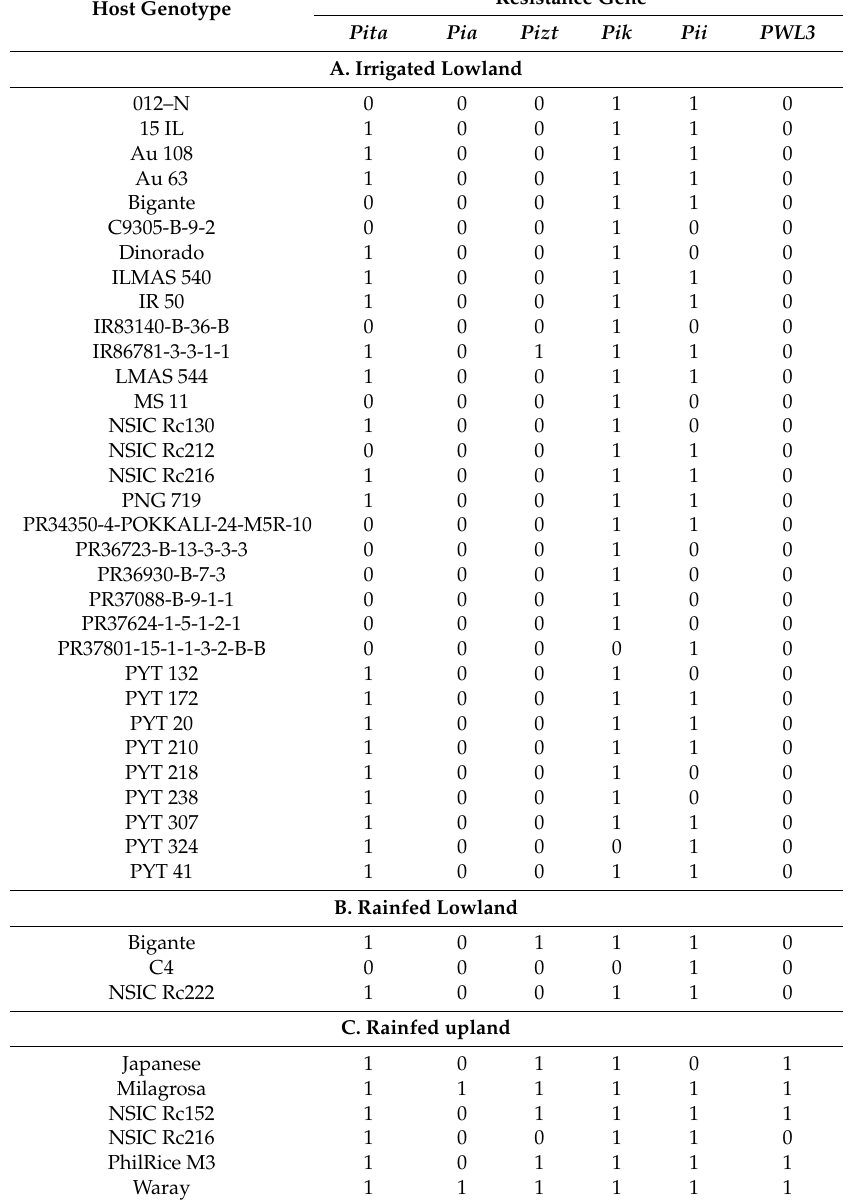
Table 3. Resistance genes identified through PCR assay of M. oryzae isolates taken from each of the host genotypes in distinct